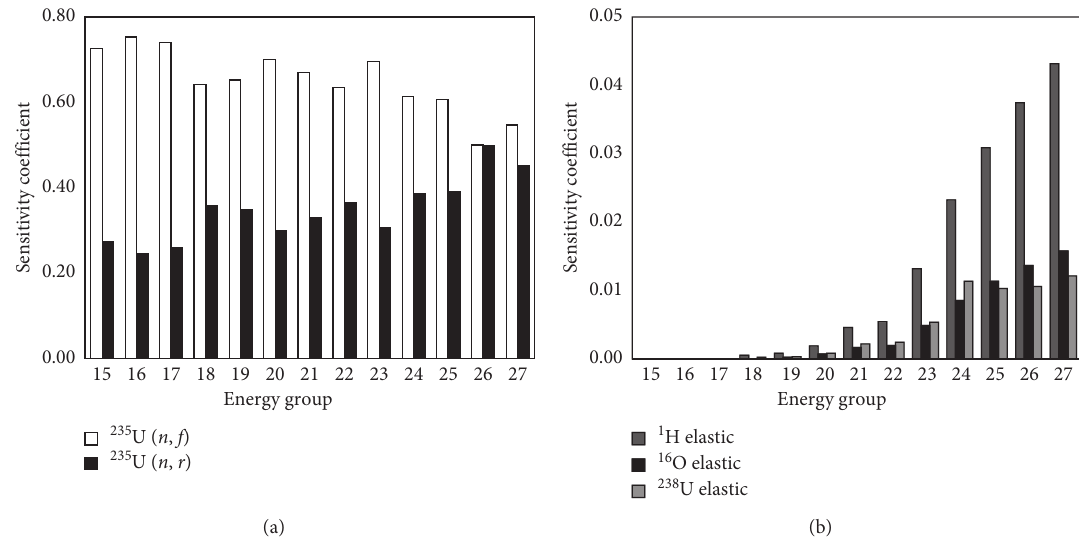
Figure 7: The top five most sensitive sources to the 235 U effective resonance absorption XS and the corresponding implicit sensitivity coefficients. (a) Sensitivity coefficients to 235 U fission and radiation capture. (b) Sensitivity coefficients to other three reactions.